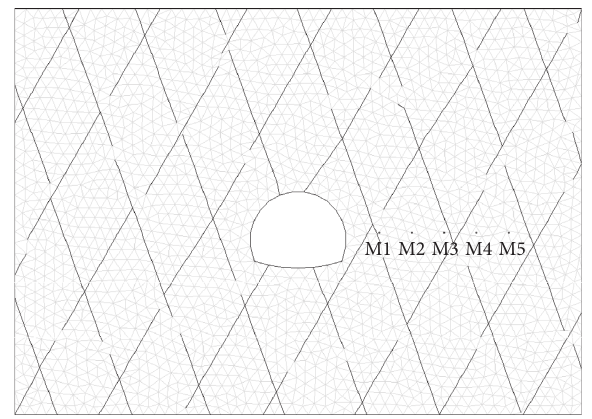
Figure 5: Computational model of the Xiucun